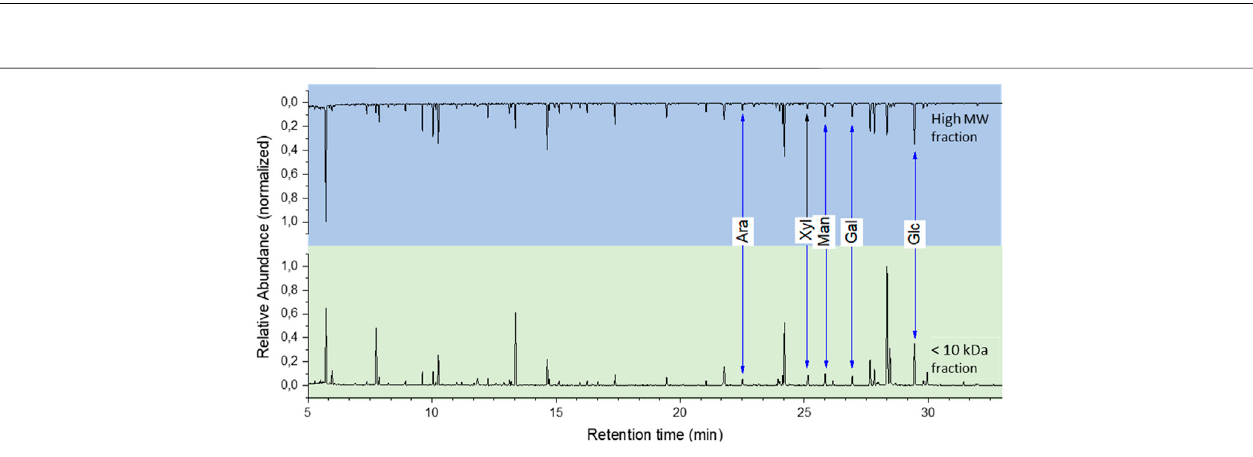
Here, about 95% (w/v) of the originally dissolved metal ions have precipitated at a pH between 7.5 and 8.0. In contrast to this observation, over 60% (w/v) of Eu 3+ -ions remained in solution